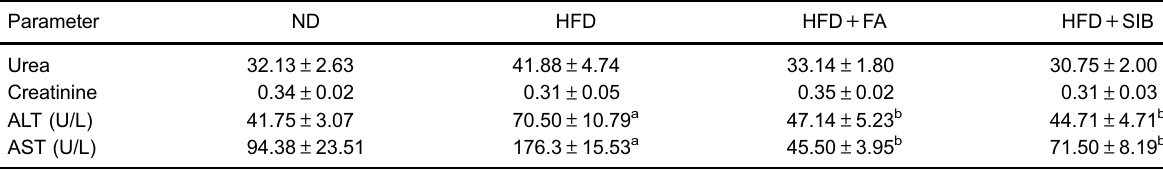
Table 4. Effects of ferulic acid (FA) and sibutramine (SIB) treatments on serum levels of urea, creatinine, alanine aminotransferase (ALT) and aspartate aminotransferase (AST), in mice fed experimental diets for 15